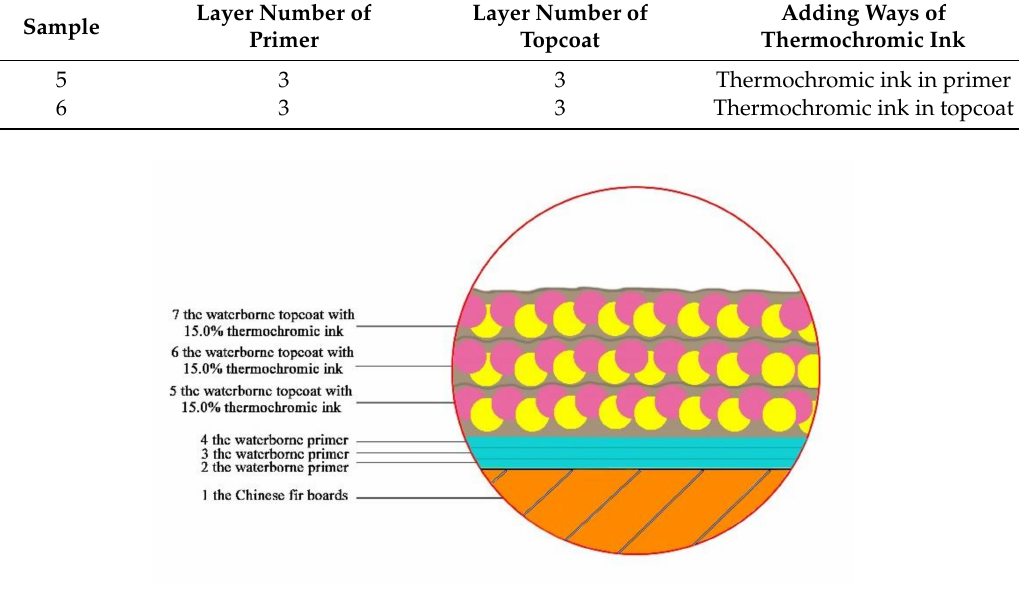
Figure 1. A schematic of sample